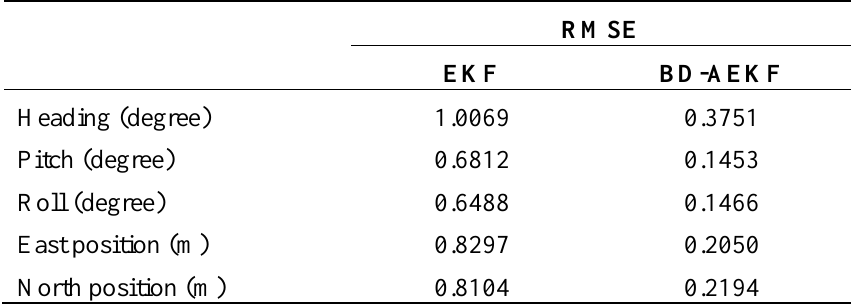
Table 2. Comparison of errors for EKF and BD-AEKF ( ).